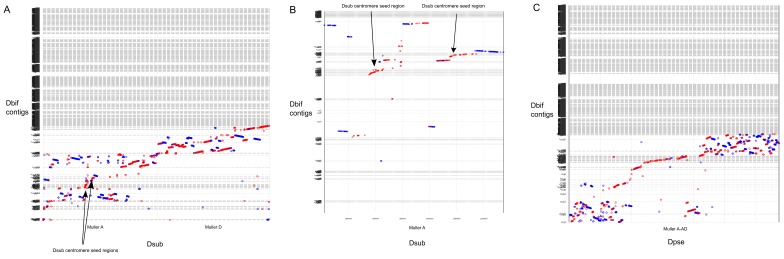
Whole genome alignments (MUMmer) of draft Drosophila bifasciata genome contigs with (A) both Muller A and D of D. subobscura and (B) highlighting the Muller A centromere seed regions.Many small contigs in the D. bifasciata assembly map to the D. subobscura seed region which is indicative of a highly repetitive and more poorly assembled region (i.e., pericentromere) in D. bifasciata. (C) Alignments of D. bifasciata contigs with the fused Muller A-AD of D. pseudoobscura show sequence similarity over the large metacentric pericentromere of Muller A-AD.